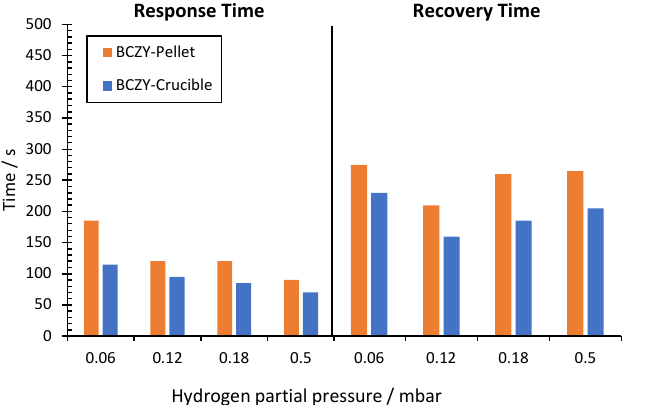
Figure 9. Response and recovery times for different hydrogen partial pressures for BCZY-Pellet and BCZY-Crucible sensors.